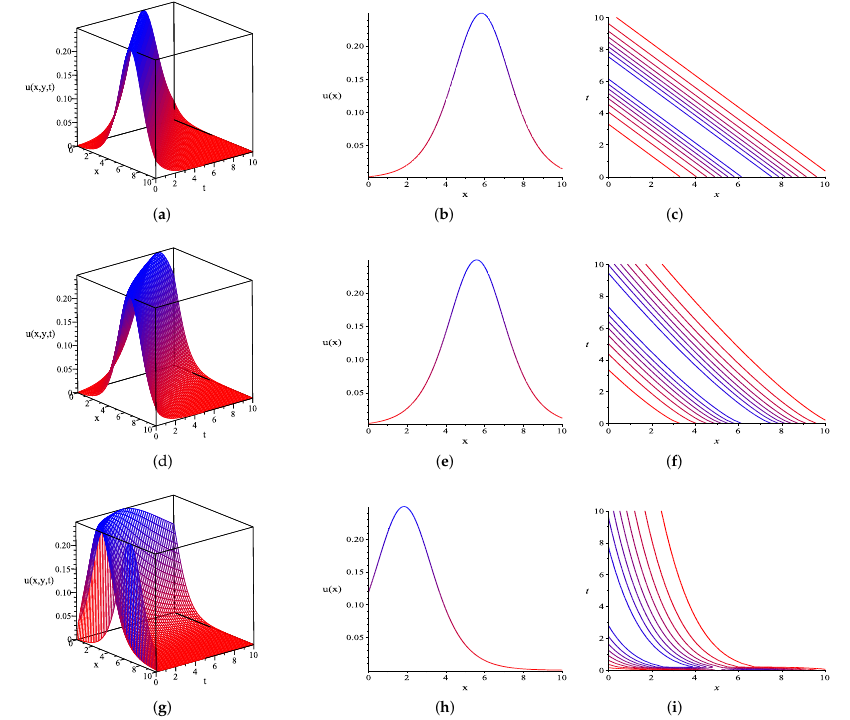
Figure 1. Associated plots of u ( x , y , t ) in Equation (30) obtained using the Exp-function method: ( a – c ) 3-D plot, 2-D plot, and contour plot, respectively when α = 1; ( d – f ) 3-D plot, 2-D plot, and contour plot, respectively when α = 0.8; ( g – i ) 3-D plot, 2-D plot, and contour plot, respectively when α = 0.2.